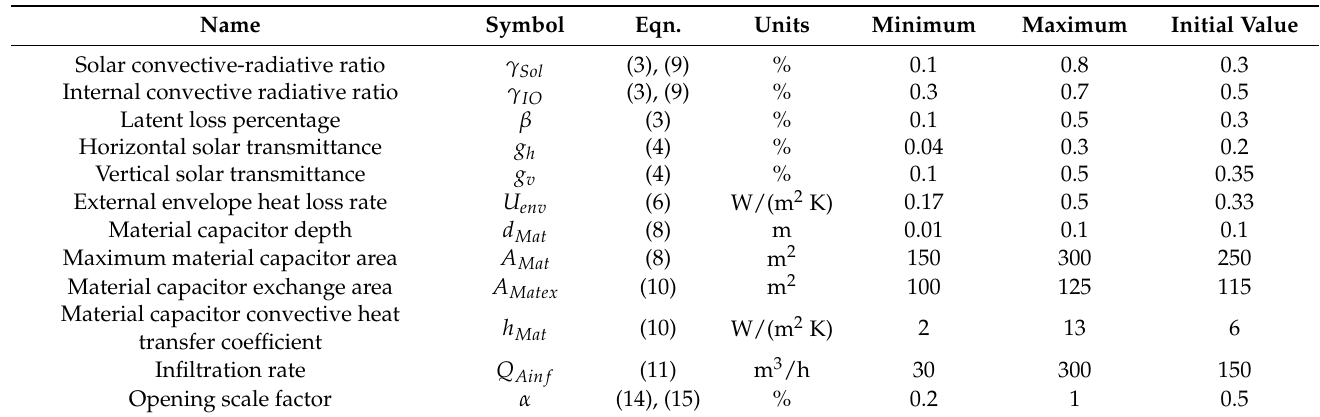
Table 3. Maximum and minimum limits and initial values for auto-calibration